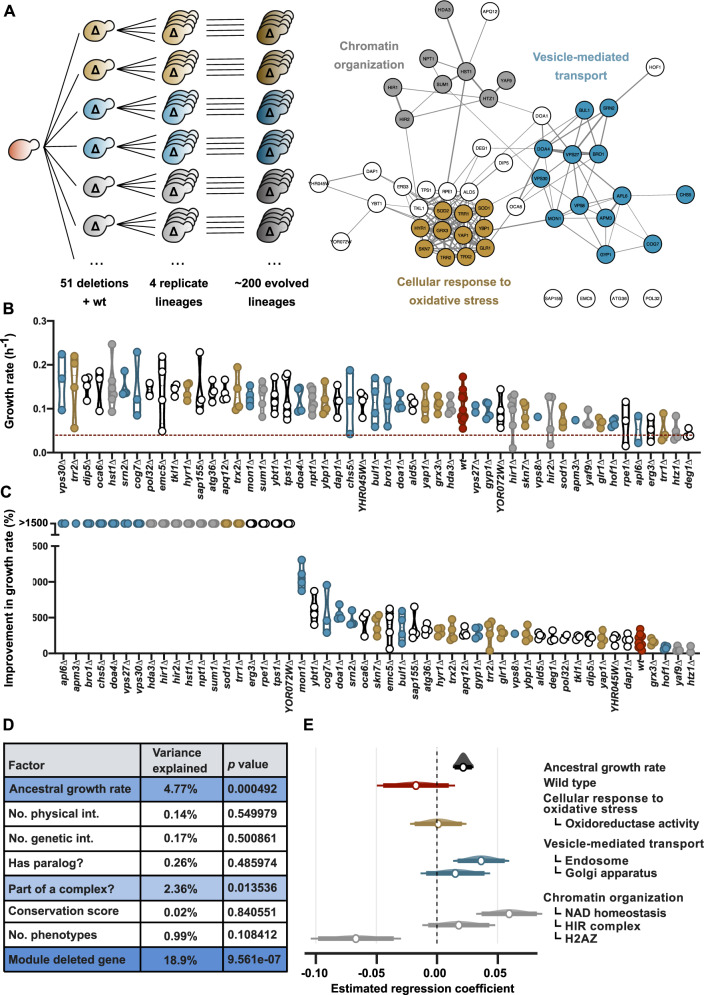
Deletion strains greatly improve growth during adaptive evolution. (A) Schematic overview of the evolution experiment and gene network with all selected genes. Strains with deletions in different modules of the genetic network underlying resistance to oxidative stress are evolved in quadruplicate under paraquat stress for 150 generations. Genes in the network are colored corresponding to the indicated cellular processes they belong to. The color scheme is maintained throughout the figure. (B) Growth rates of one fit clone from each evolved population on rich medium with 2% (w/v) glycerol and 0.125 mM paraquat. Each point represents the mean of four replicate measurements. The deletion strains are sorted according to their average growth rate after evolution. The red dotted line represents the average growth rate of the wild type before evolution. (C) Improvement in growth rate of one fit clone for each evolved population on rich medium with glycerol and paraquat. (D) Result of a multivariate linear model analysis of the growth rate after evolution in function of various biological parameters. Shades of blue correspond with significance level. (E) Estimated regression coefficient per network module of the deleted gene with their 95% confidence intervals (multivariate linear regression).